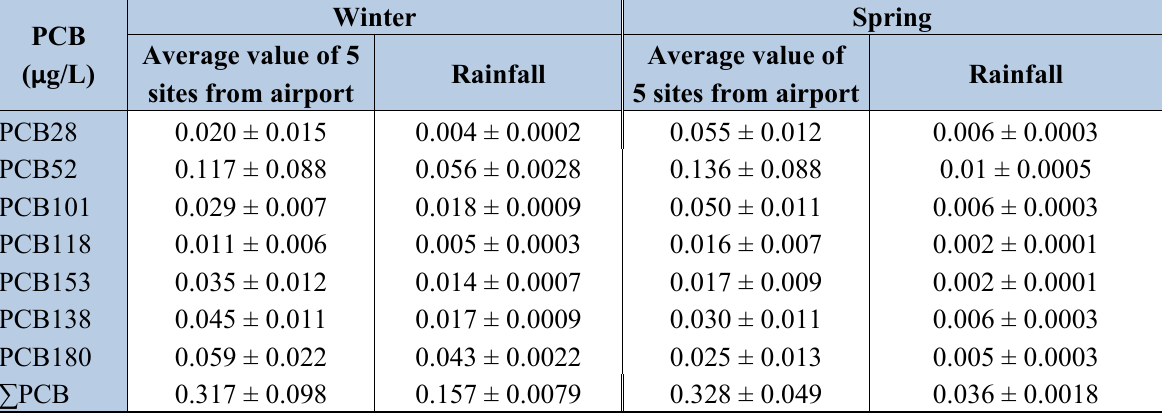
Table 6. The average PCB concentration determined in the runoff and rainfall water